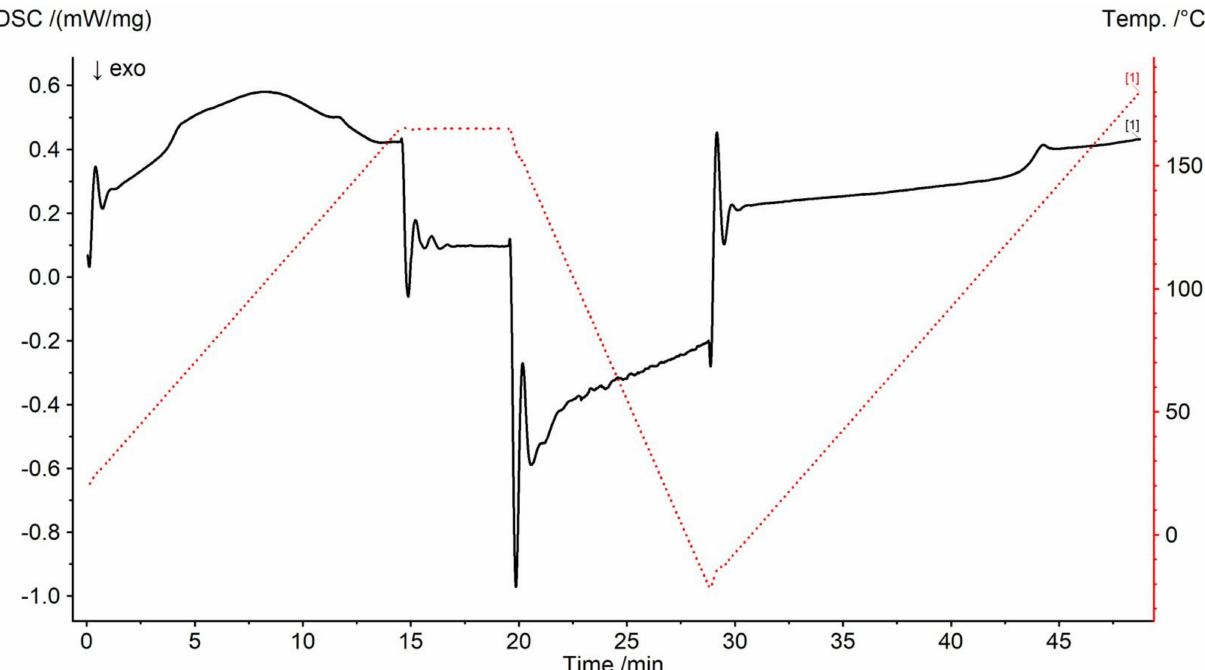
Figure 2. Thermogram of simultaneous residual dehydration and subsequent determination of the glass transition of maltotriose. The endothermic profile of the signal, which shows the release of water, can be clearly seen as a hump during the first heating